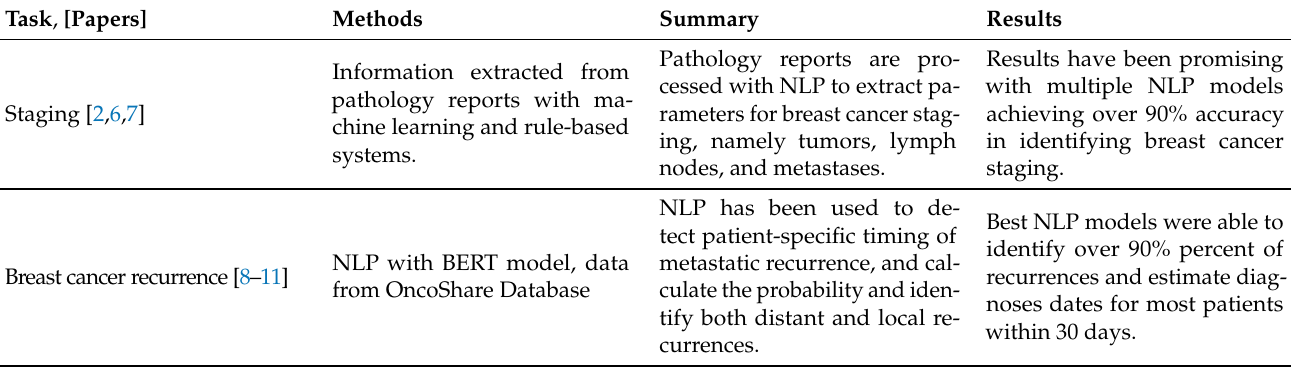
Table 2. Category and summary of NLP in breast imaging applications based on clinical